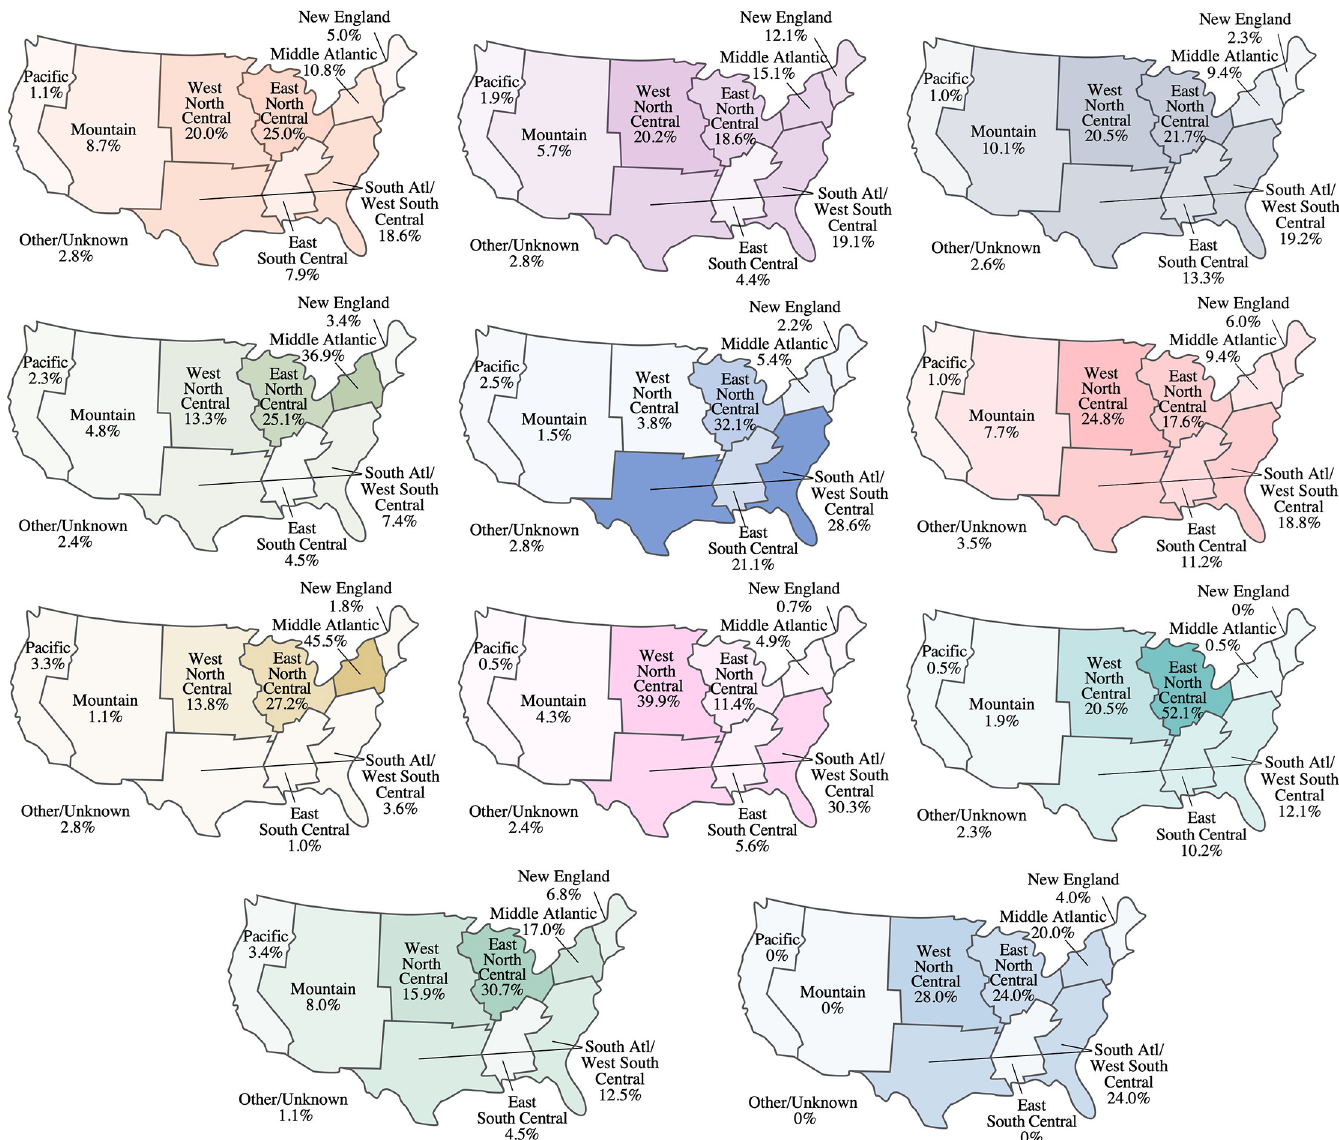
Fig 3. Geographical distribution of index treatment use. a) Dexamethasone (n = 9,269), b) Dexamethasone + remdesivir (n = 3,891), c) Azithromycin + dexamethasone (n = 3,405), d) Azithromycin (n = 3,373), e) Remdesivir (n = 3,002), f) Azithromycin + dexamethasone + remdesivir (n = 1,747), G) Azithromycin + remdesivir (n = 615), h) Convalescent plasma + dexamethasone + remdesivir (n = 552), i) Convalescent plasma (n = 215), j) Hydroxychloroquine (n = 88), k) Azithromycin + hydroxychloroquine (n = 25). � Includes Alaska and Hawaii. Data for the tocilizumab cohort are not presented due to small sample